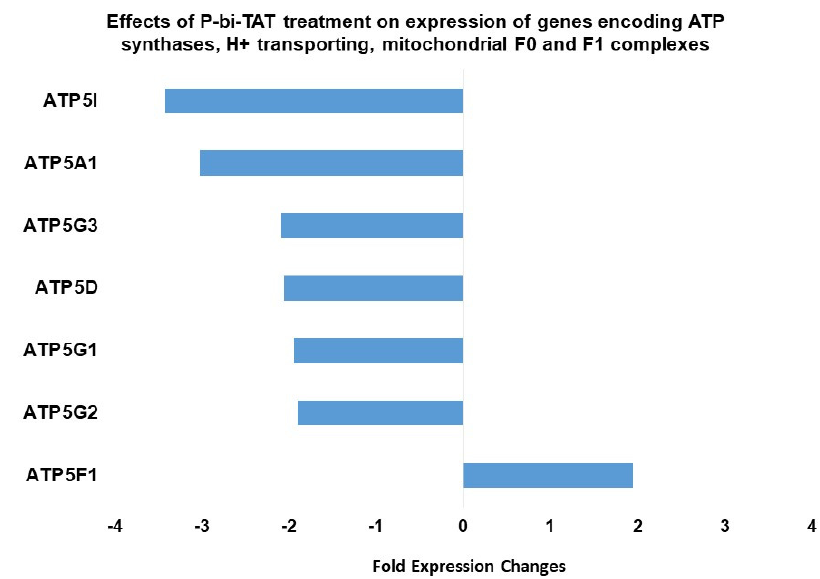
Figure 2. Effects of P-bi-TAT treatment on expression of genes in GBM cells encoding ATP synthases, H + transporting mitochondrial F 0 and F 1 complexes. Listed values report fold expression changes (log scale) for corresponding genes ( p < 0.05).